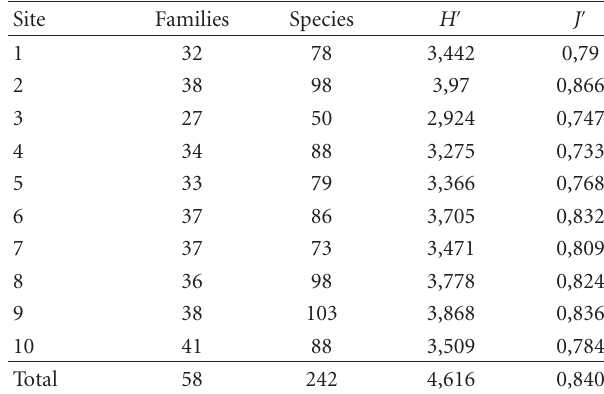
Table 2: Number of families and species, Shannon diversity index ( H (cid:4) ), and Pielou evenness index ( J (cid:4) ) from ten sites of seasonal semideciduous forest in southeastern